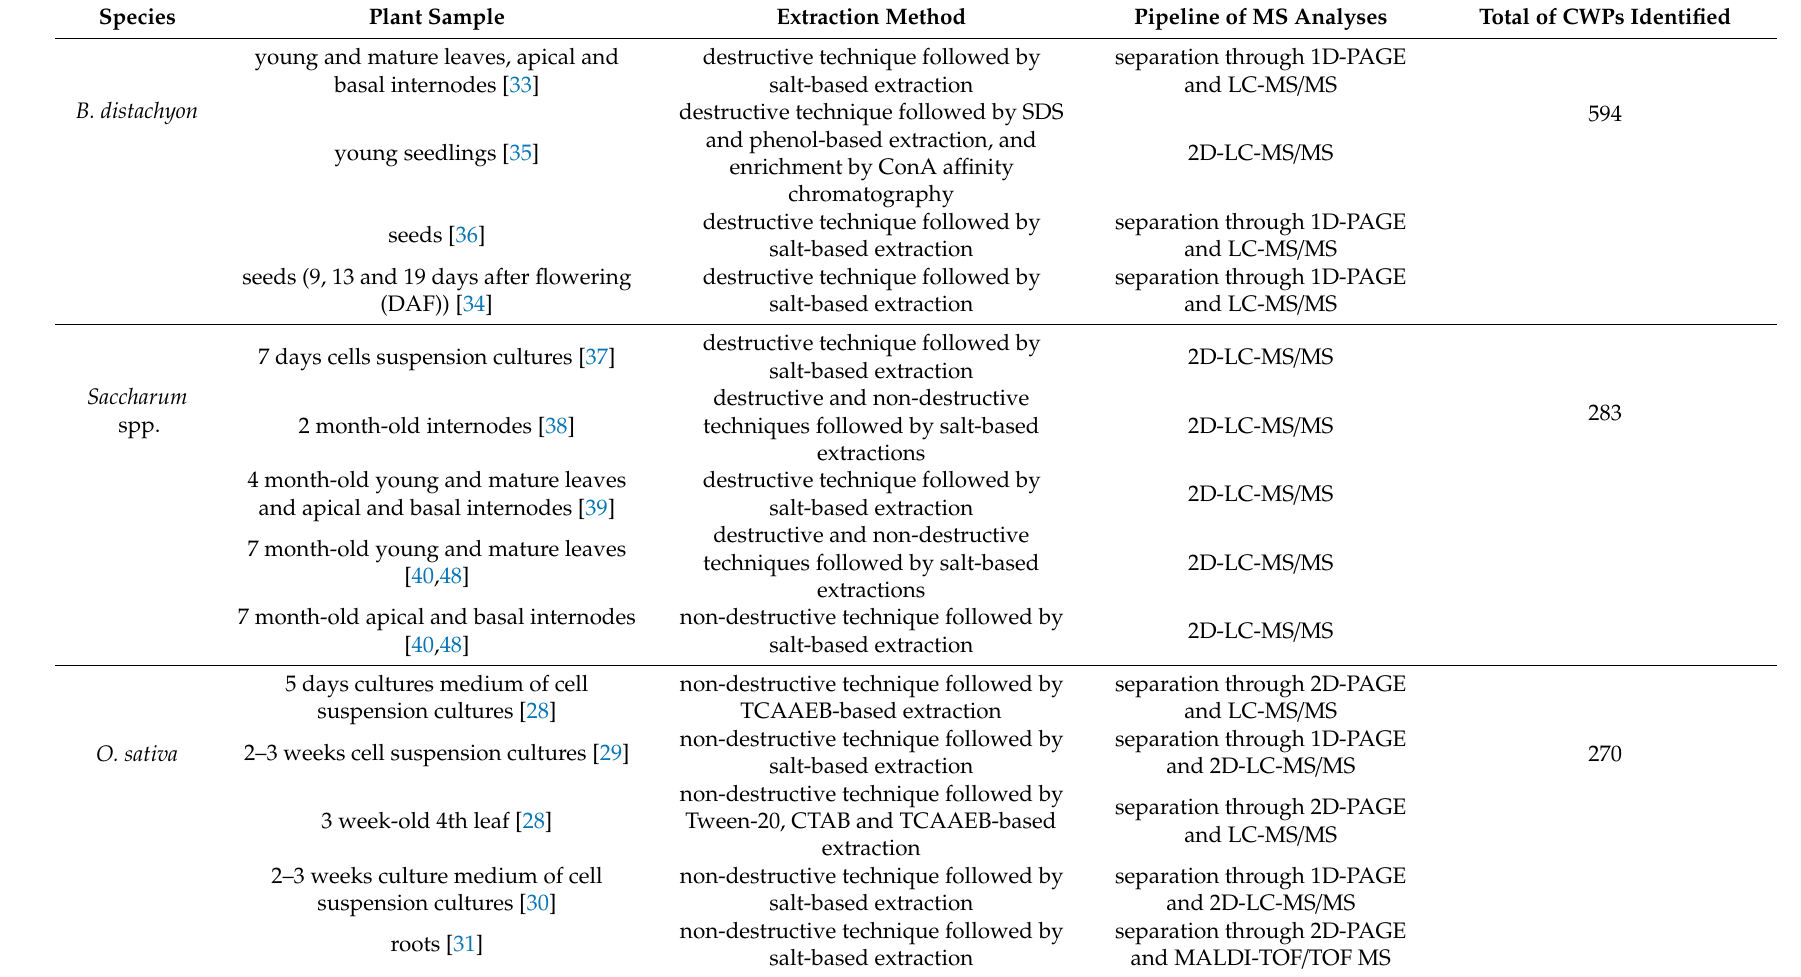
Table 1. Summary of the plant samples, extraction and mass spectrometry methods used in monocot CWP